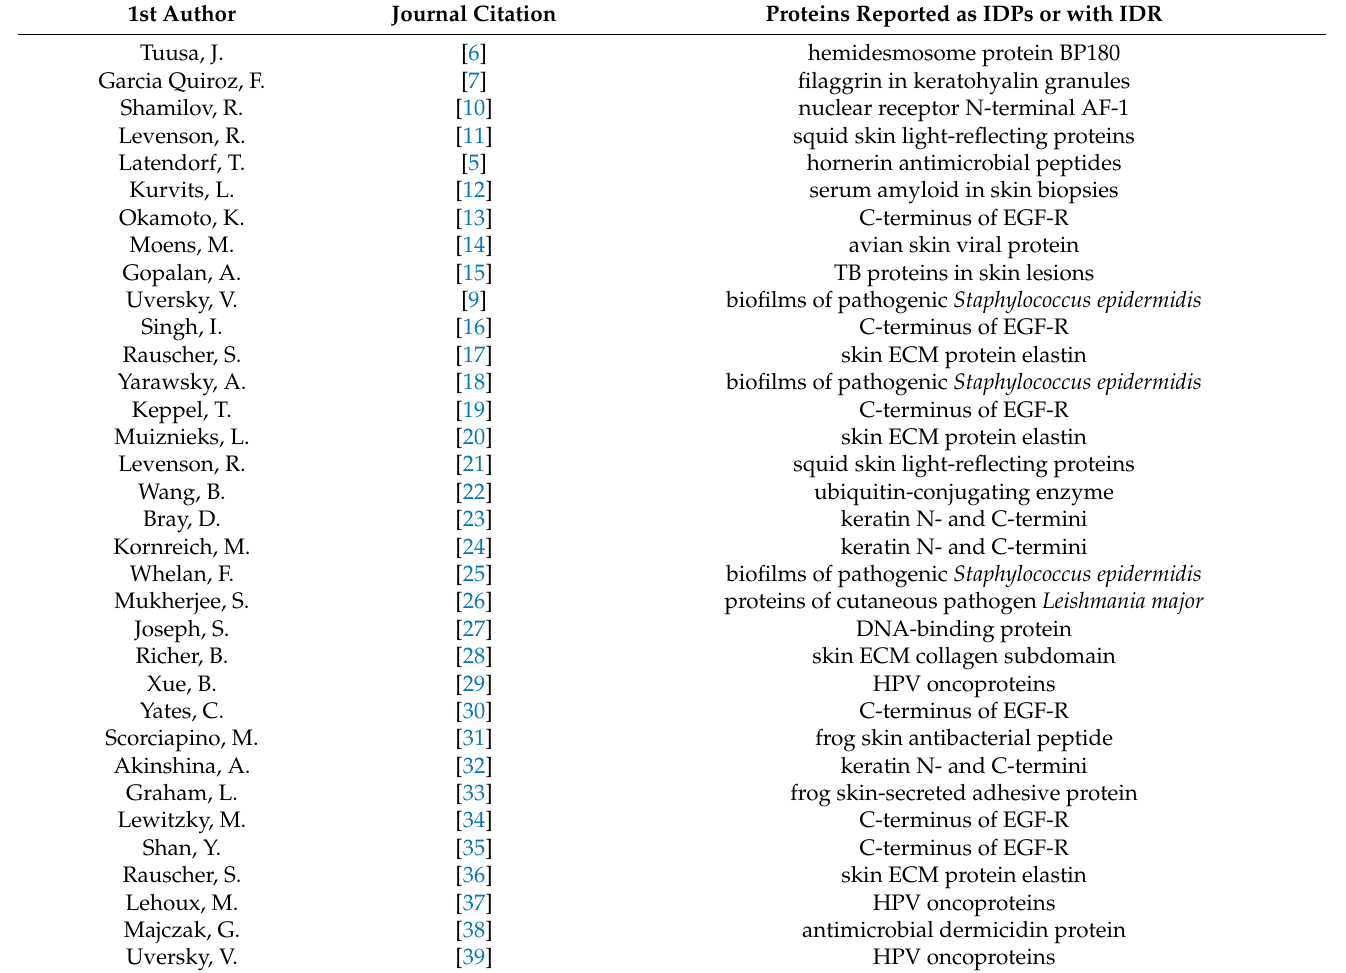
Table 1. Search hits (primary reports and reviews) presented in reverse chronological order. PubMed search parameters: conducted on 26 April 2021 with [(skin OR cutaneous OR epiderm* OR keratinocyte) AND (“unstructured protein” OR “intrinsic disorder” OR “intrinsically disordered”)]. Unless otherwise noted (e.g., frog, squid, bacterial), cited proteins are from human samples. Intrinsic AND disorder, as separate words with the “AND” operator, were not used because they did not distinguish hits on intrinsic disease states from protein conformation references. Returned publications were manually reviewed by text searching for how the keywords appeared in the publication to remove these coincidental hits. Inclusion of “unstructured” alone produced excess off-target hits such as “unstructured interviews”, “unstructured content”, and “unstructured review”. We consider the table’s hits representational, if not all-inclusive, and apologize to any researchers not included due to the search parameters or who have published in journals not indexed by MEDLINE. The term “intrinsically disordered” alone returned 5654 PubMed hits. Abbreviations: AF-1, activating function 1; BP180, bullous pemphigoid; C, carboxyl; N, amino; ECM, extracellular matrix; EGF-R, epidermal growth factor receptor; HPV, human papilloma virus; TB,